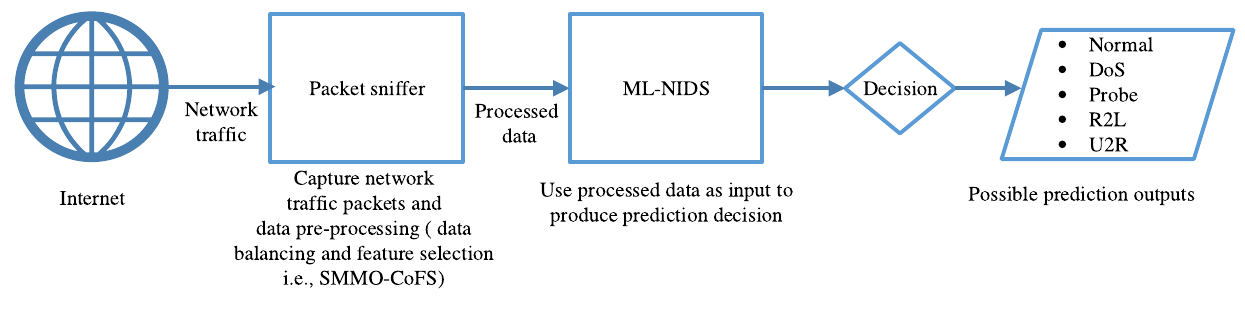
Fig. 2 The scheme of SMMO-CoFS-based NIDS